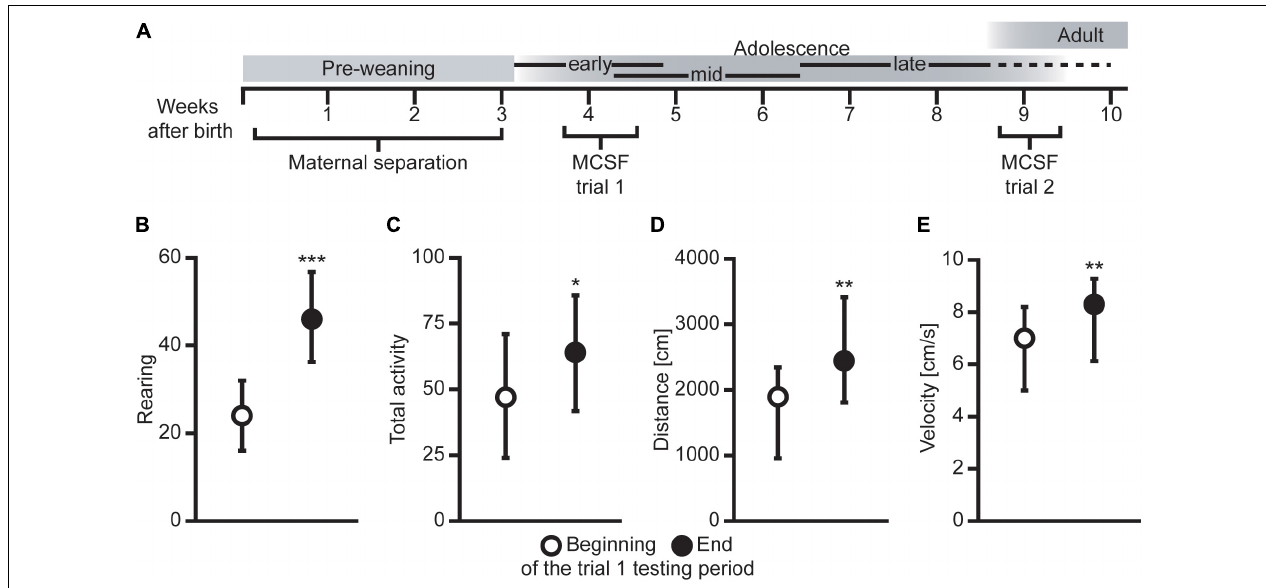
FIGURE 1 | (A) Overview of the experimental outline with age in weeks and approximate developmental stages [adopted from Lundberg et al. (2019) with permission]. Difference in (B) rearing, (C) total activity (i.e., sum of all frequencies), (D) total distance traveled (cm), and ( E ) mean velocity (cm/s) between animals tested in the beginning (first half, n = 39) compared to the end (second half, n = 32) of the MCSF trial 1 testing period. Data presented as median with upper and lower quartiles. * P < 0.05, ** P < 0.01, *** P < 0.001, Mann–Whitney U